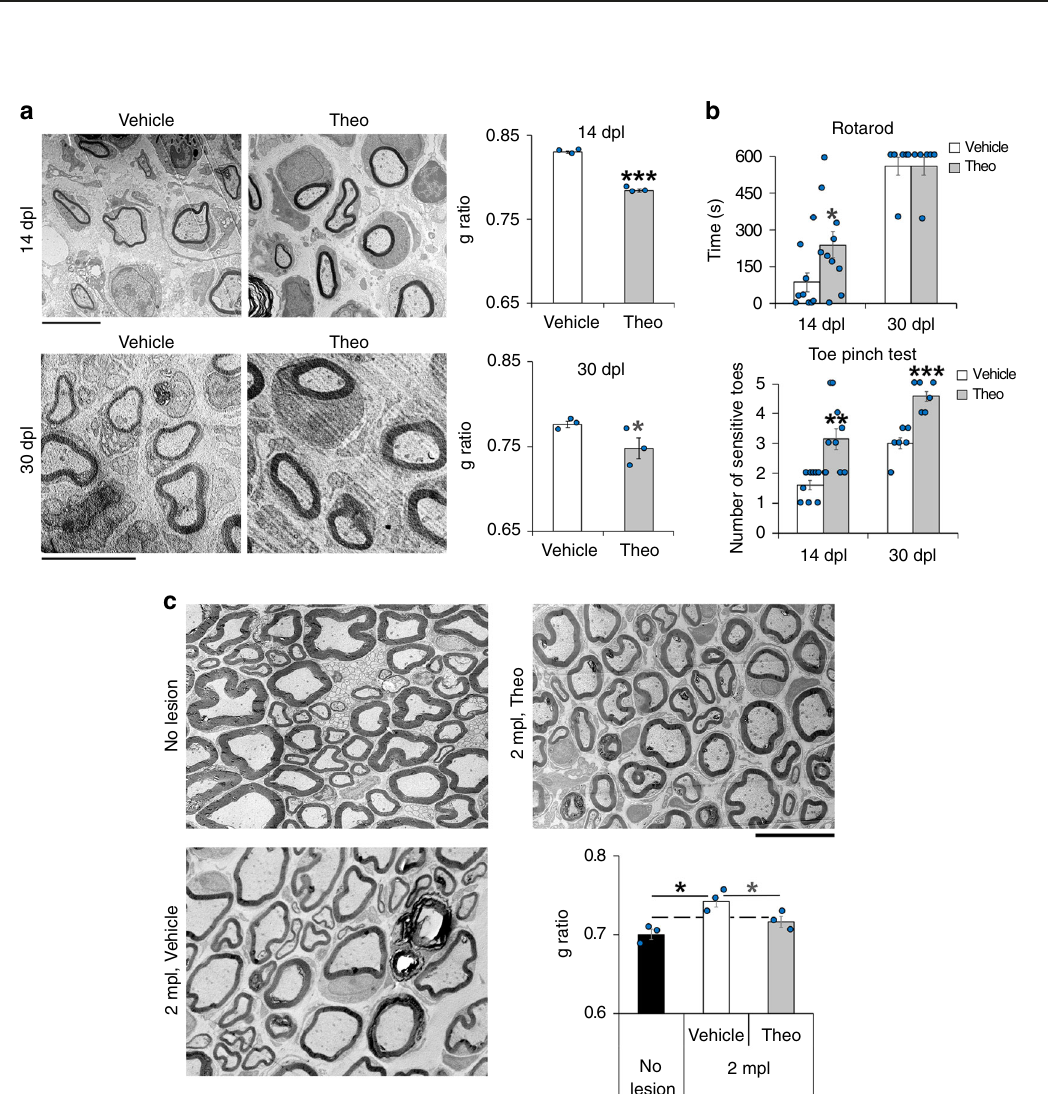
Fig. 7 Theophylline increases Sox10, Krox20, and P0 expression and eEF1A1 deacetylation. a HDAC2 (12dpl: n = 3, p = 0.025883, 14dpl: n = 5, p = 0.011697), Sox10 (12dpl: n = 3, p = 0.031422, 14dpl: n = 3 – 4, p = 0.032671), Krox20 (12dpl: n = 3, p = 0.030486, 14dpl and 30dpl: n = 7, p = 0.033493 and 0.022041) and P0 (12dpl: n = 3, p = 0.022239, 14dpl: n = 4-5, p = 0.019084, 30dpl: n = 6, p = 0.0456) Western blots at 12, 14 and 30dpl in lysates of crushed (Cr) or contralateral (Co) sciatic nerves of mice treated at 10dpl with theophylline (Theo) or vehicle (Veh.) for 2 days (12dpl) or 4 days (14 and 30dpl), and quanti fi cation normalized to GAPDH and Co. b , c EEF1A1 IP and Ac-eEF1A Western blot ( b ) and Ac-eEF1A and S100 (SC marker) co-